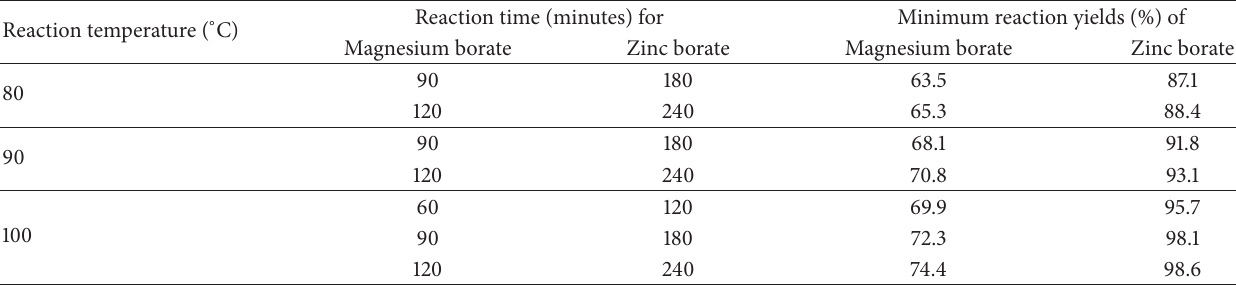
Table 6: Minimum obtained reaction yields (%) of the synthesised magnesium borate and zinc borate minerals.